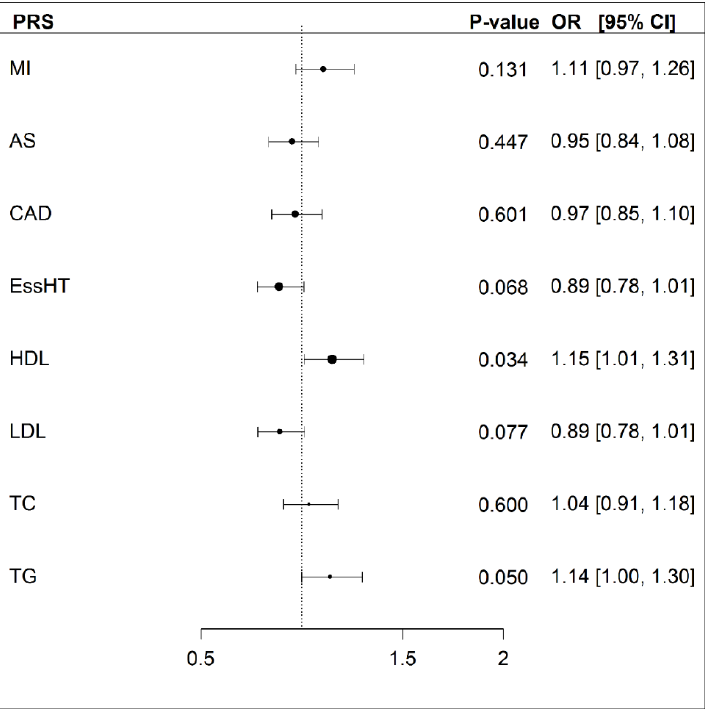
Figure 2. Forest plot showing the associations of different cardiovascular PRS with exceptional